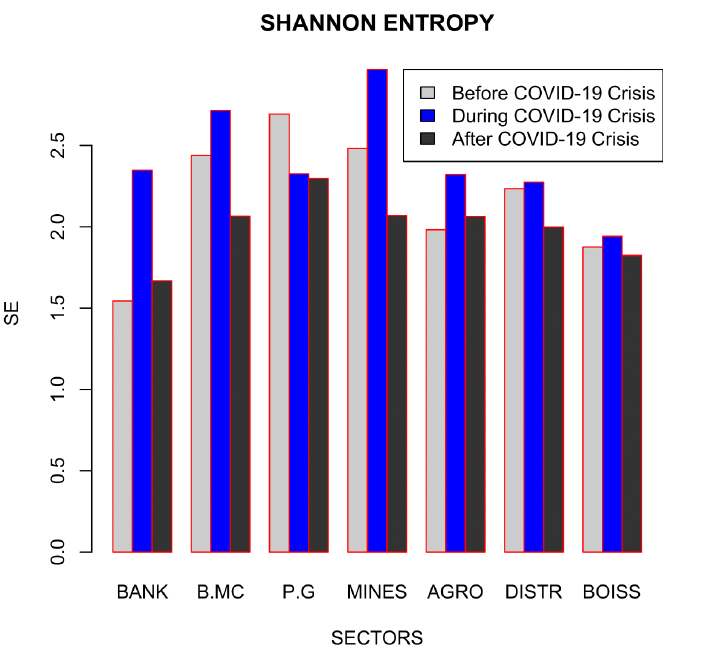
Figure 11. Shannon entropy using a maximum likelihood (ML) estimator during the three periods for all sectoral